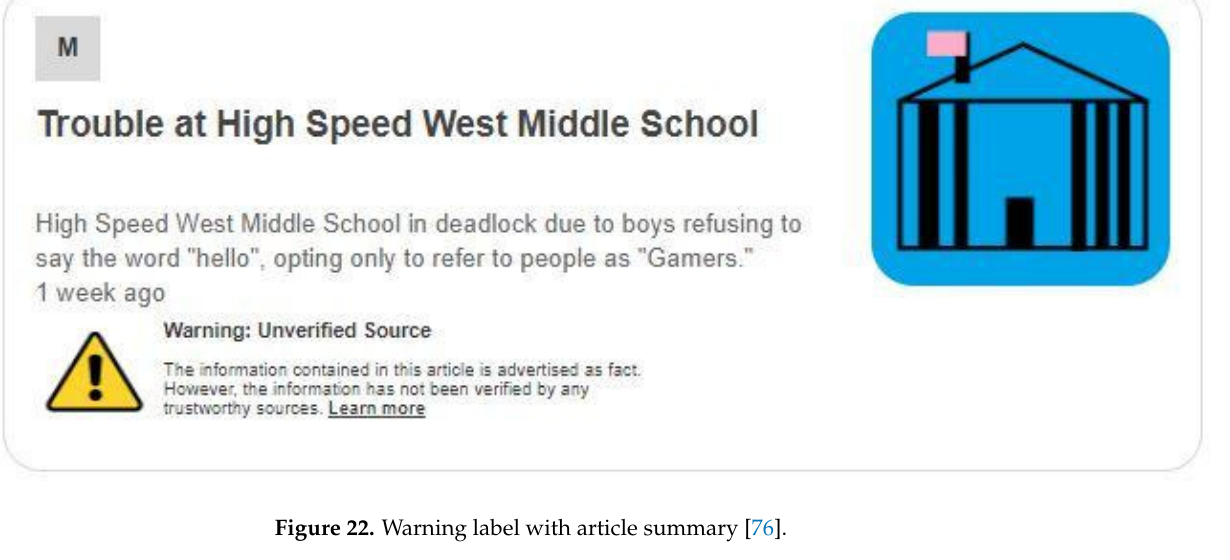
Figure 22. Warning label with article summary [76].